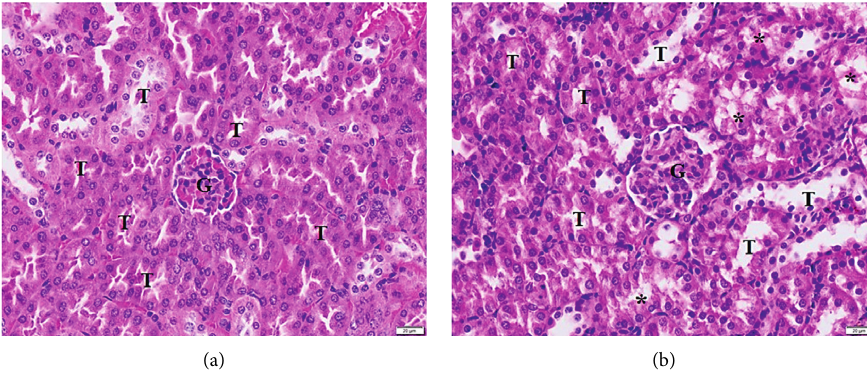
Figure 2: Hematoxylin and eosin (H&E)-stained kidney sections from the control and P. berghei -infected groups. The kidney section of the control group shows a normal glomerulus and typical tubular cells (a). The kidney section of the P. berghei -infected group presented an area of tubular necrosis (asterisks) and a dilated lumen of renal tubules (b). 200x magnification, bar � 20 μ m. G, glomerulus; T, renal tubule.